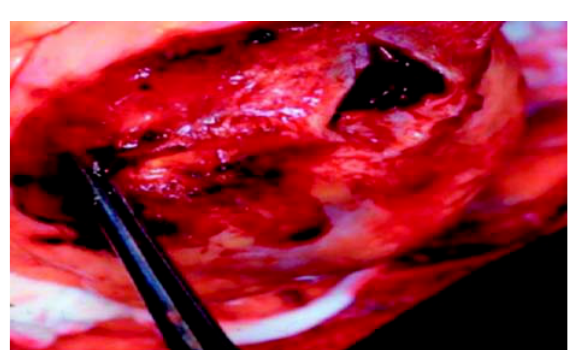
Fig. 1 – Rotura cardíaca aguda.